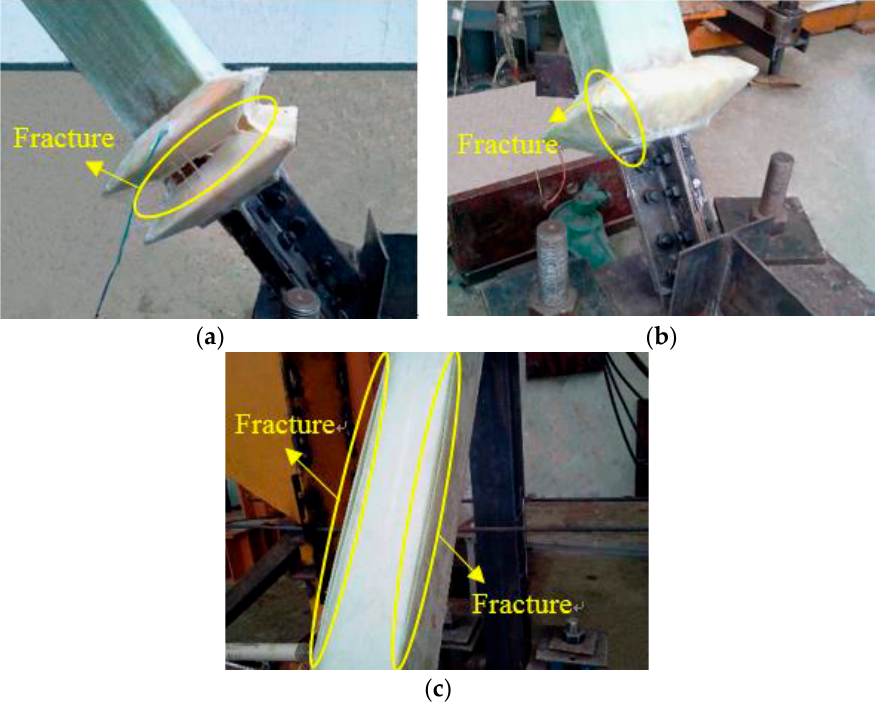
Figure 8. Failure modes: ( a ) tensile fracture of expansion joint of S1; ( b ) tensile fracture of expansion joint of S1; and ( c ) GFRP burst damage of S4.